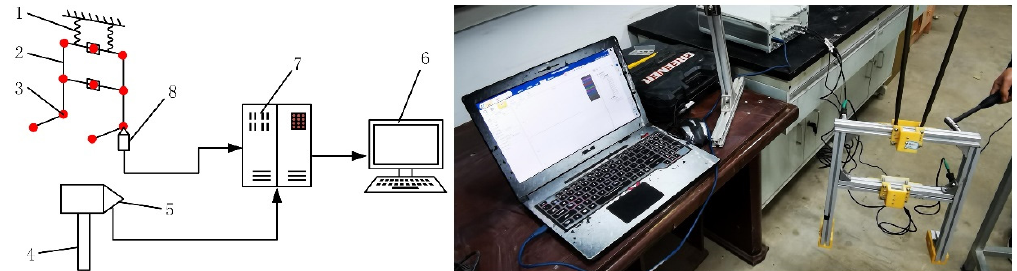
Figure 19. Experimental modal test and analysis system. 1: spring; 2: installation frame; 3: test point; 4: modal force hammer; 5: force sensor; 6: PC; 7: data acquisition and analysis module; and 8: acceleration sensor.